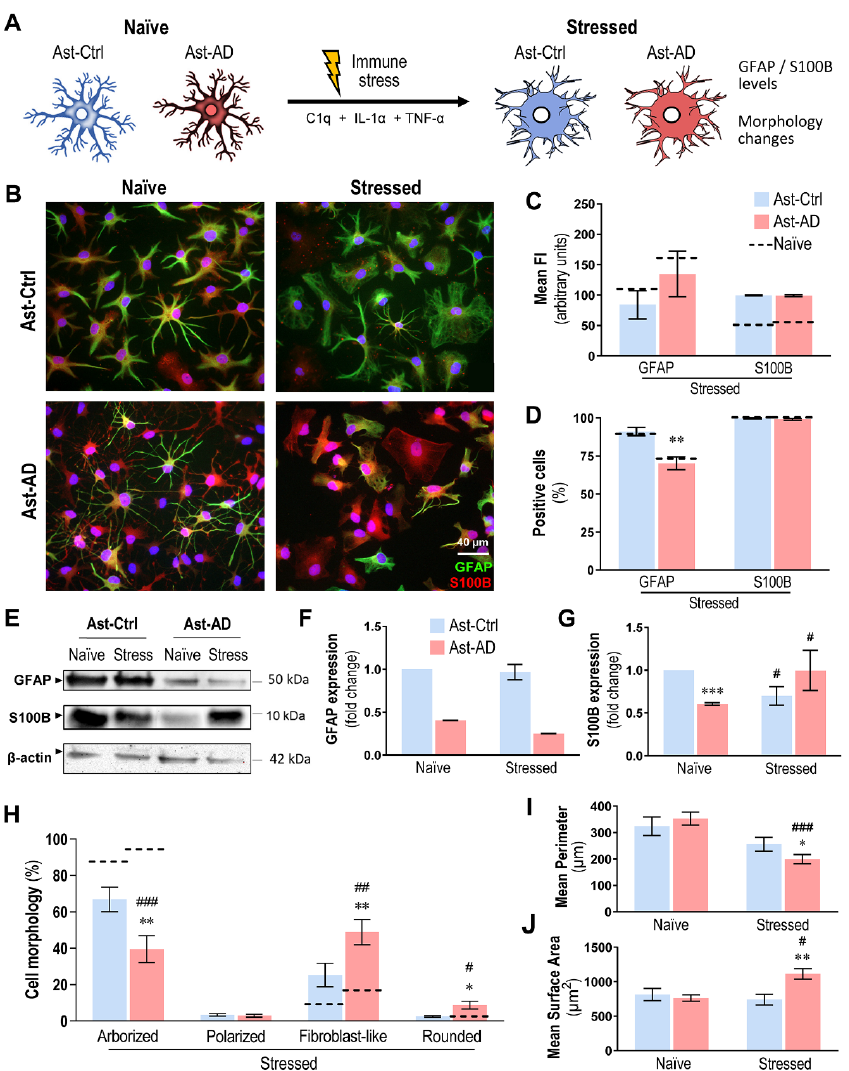
Figure 7. Immunostimulation with C1q + IL-1 α + TNF- α maintains a reduced number of GFAP- positive Ast-AD cells, while it enhances S100B expression and switches the arborized Ast-AD stressed cells toward fibroblast-like and round cells. ( A ) Schematic representation of the 48 h im- munostimulation model of astrocytes from AD and Ctrl samples (Ast-AD and Ast-Ctrl, respec- tively), as detailed in Materials and Methods. ( B ) Representative immunofluorescence images of naïve (non-immunostimulated) and stressed (immunostimulated) Ast-Ctrl and Ast-AD cells. Astro- cytes were double-labeled with GFAP (green) and S100B (red). Nuclei were counterstained with Hoechst. ( C ) GFAP and S100B mean fluorescent intensities (FIs) of stressed Ast-Ctrl and Ast-AD cells vs. naïve ones (dashed line). ( D ) Number of GFAP- and S100B-positive cells in stressed Ast- Ctrl and Ast-AD cells vs. naïve ones (dashed line). ( E ) Representative Western blot images of GFAP and S100B cellular levels, with the respective ( F ) GFAP and ( G ) S100B densitometric quantifications. ( H ) Percentage of arborized, polarized, fibroblast-like and rounded cell morphologies after im- munostimulation of Ast-Ctrl and Ast-AD cells vs. respective naïve cells (dashed lines). ( I ) Mean perimeter and ( J ) mean surface area of naïve and stressed Ast-Ctrl and Ast-AD cells. Scale bar cor- responds to 40 µm ( B ). Results are mean ± SEM from at least 4 independent experiments. For GFAP Western blot quantification, a pool of 4 samples was used. Two-tailed Student’s t -test: * p < 0.05, **